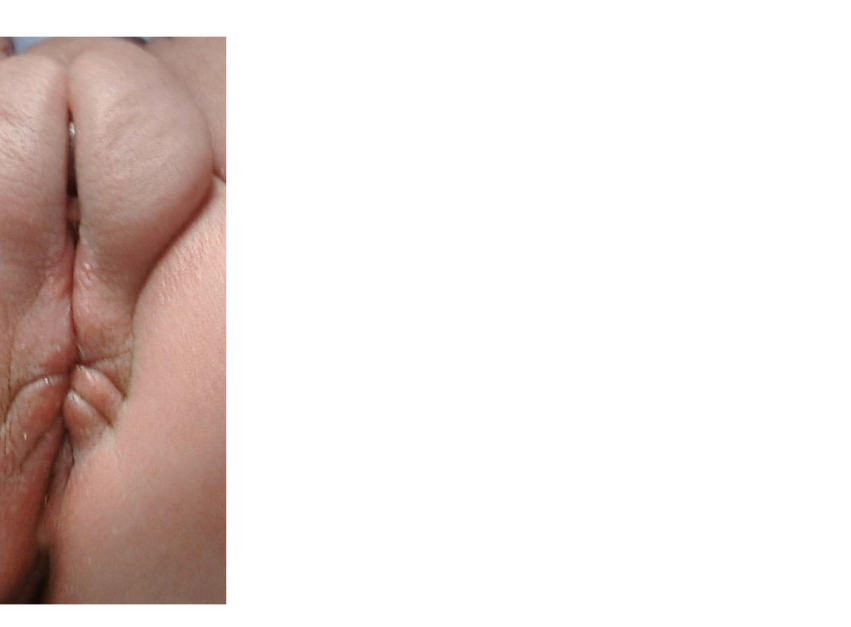
Figure 4. Picture of a female newborn with AA and a perineal groove. The patient also has Pierre- Robin